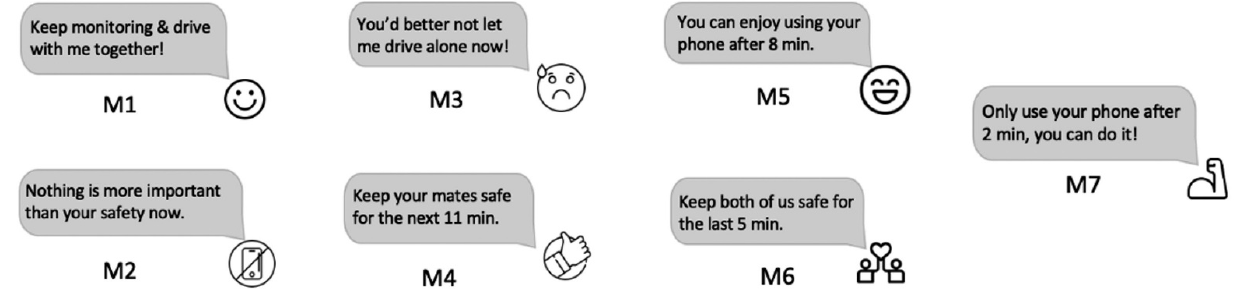
Figure 2. Affective messages M1 to M7 as displayed in the HUD when driving with the AMC. Mes- sages are displayed in position 5 (Figure 1b). Messages are displayed in position 5 (Figure